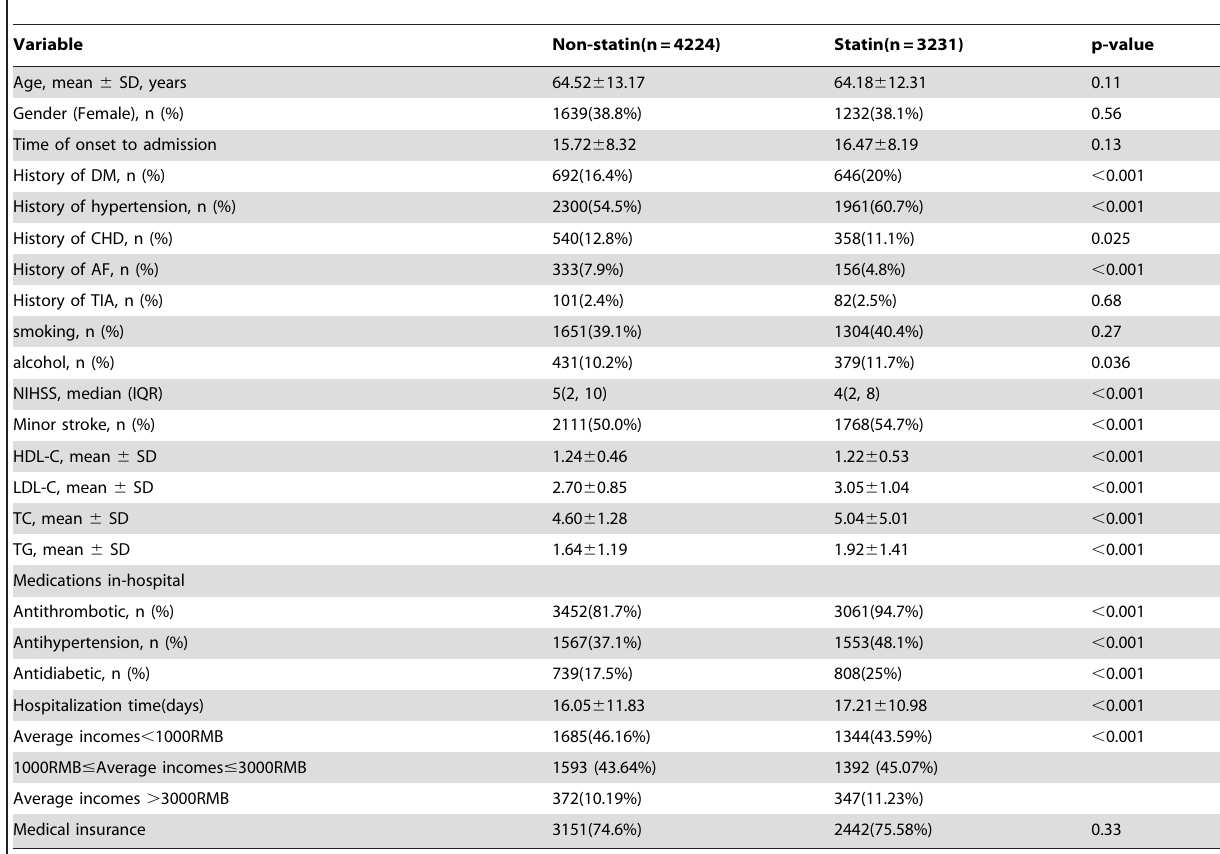
Table 1. Baseline characteristics of patients according to statin